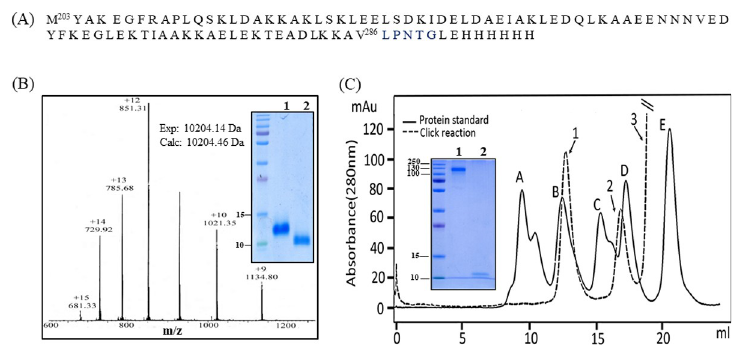
Fig 3. Purification, characterization and alkyne labeling of PspA construct. (A) Amino acid sequence of the expressed PspA 203-286 -LPNTG-His 6 , (B) ESI-MS of PspA-alkyne protein: The experimental mass of alkyne-labeled PspA was found to be 10204 Da which is in accord with the sortase-mediated installation of Gly-Gly-D-Pra ( 2 ) to the C-terminal of PspA construct. Inset shows the SDS-PAGE of the expressed PspA (lane 1) and PspA-alkyne (lane 2). (C) Semisynthesis of PspA dendrimer: CuAAC click ligation of PspA-alkyne and β -CD(N 3 ) 7 ( 1 ) was carried out at 37 C for 1 h and the reaction mixture was subjected to size-exclusion chromatography (shown with broken lines) using a Superdex 200 Increase 10/300 GL column. The individual peaks (dendrimer, peak1 and unreacted PspA-alkyne, peak 2) were pooled, concentrated and analyzed by SDS-PAGE. The last peak contains click reagents (sodium ascorbate, copper sulfate). Inset shows the SDS-PAGE profile of peak 1 (dendrimer) and peak 2 (PspA-alkyne). The chromatogram shown with solid line represents the profile of a standard sample comprising thyroglobulin (peak A, M. wt. 670000), γ -globulin (peak B, M.wt. 158000), ovalbumin (peak C, M.wt. 44000), myoglobin (peak D, 17000), and vitamin B12 (peak E, M.wt. 1350).